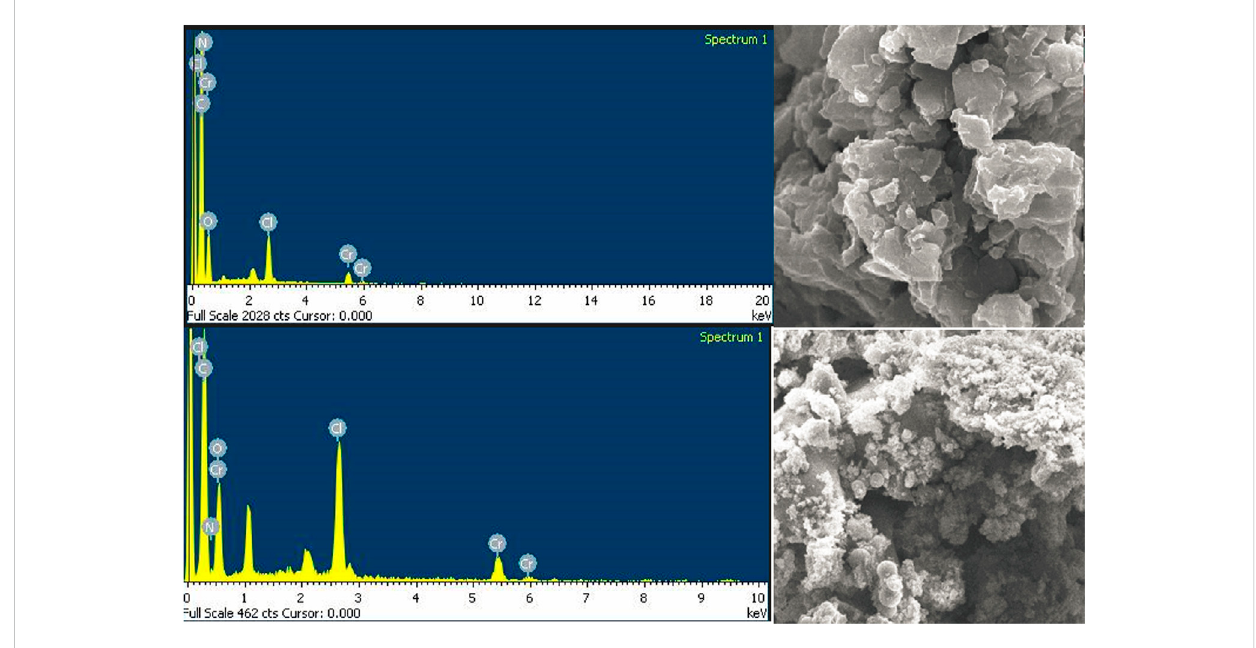
FIGURE 4 SEM-EDX images of the Cr1 (top) and Cr2 (bottom) complexes.